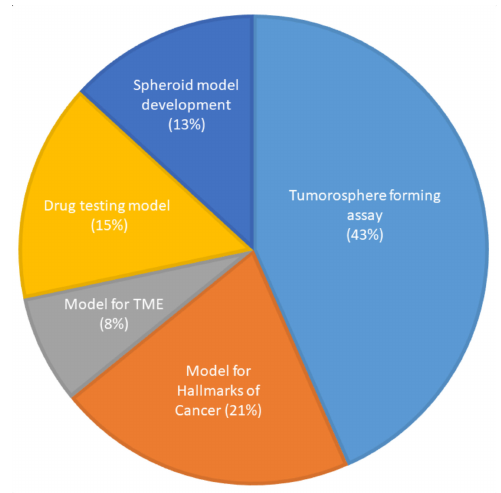
Figure 4. Use of spheroid culture in oral cancer research ( n =